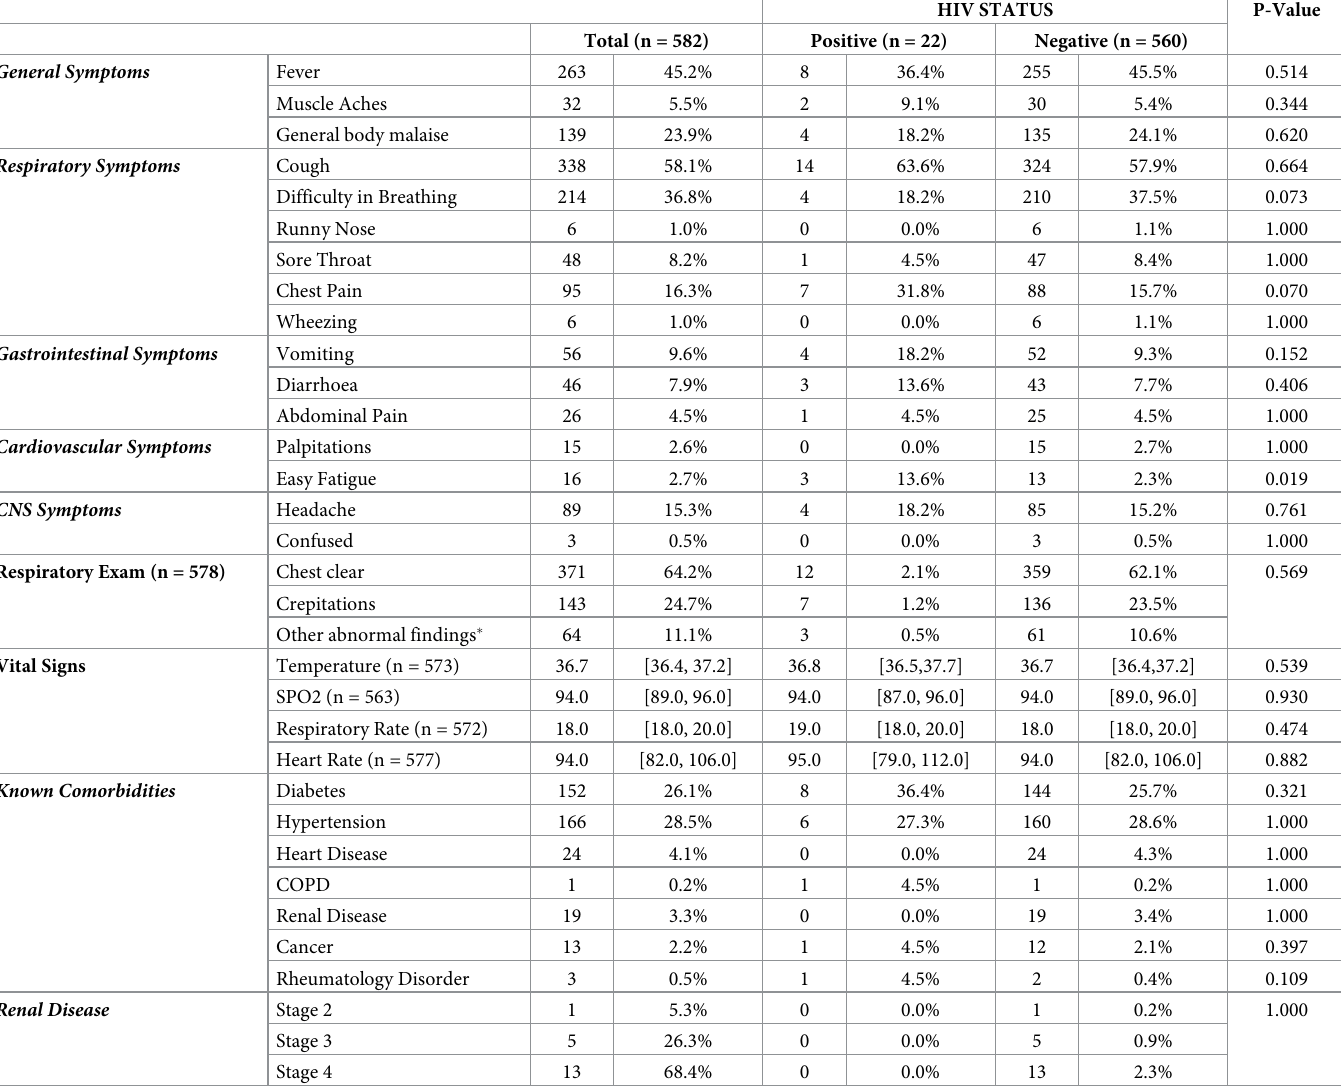
Table 2. Clinical characteristics between the HIV-positive and negative